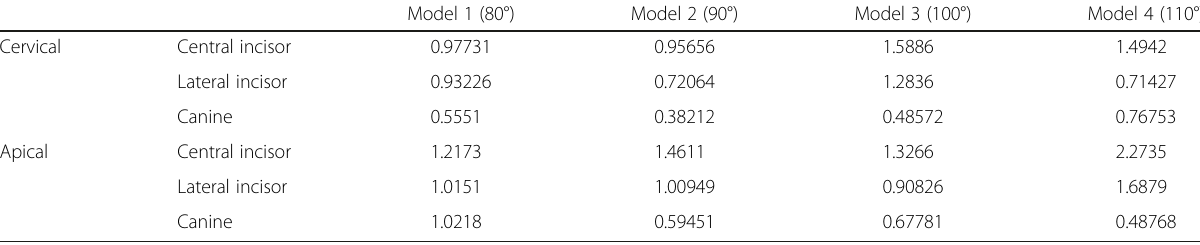
Table 3 The von Mises stress (MPa) in the PDL of the anterior teeth